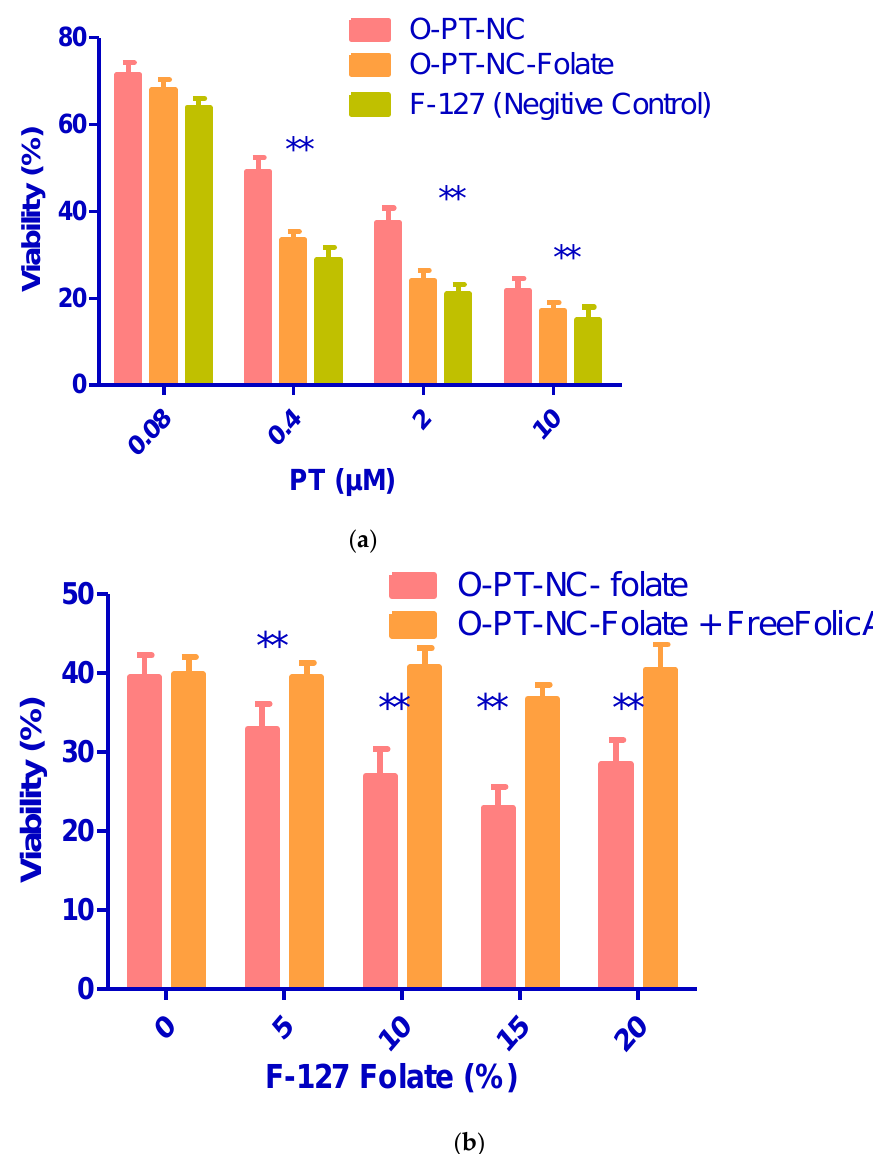
Figure 7. Viability of the human FR-positive oral cancer cell line in the presence of the targeted (O-PT-NC-Folate) and non-targeted (O-PT-NC) nano-crystals following a 48 h incubation period. The targeted nano-crystals comprised ( a ) varying levels of F127-folate with different PT concentrations and ( b ) diverse concentrations of F127-folate with 2 mM PT. Untreated cells were used as a control group, and their vitality was measured at 100%. The data were provided as the mean and standard deviation (n = 8). ** p < 0.01.